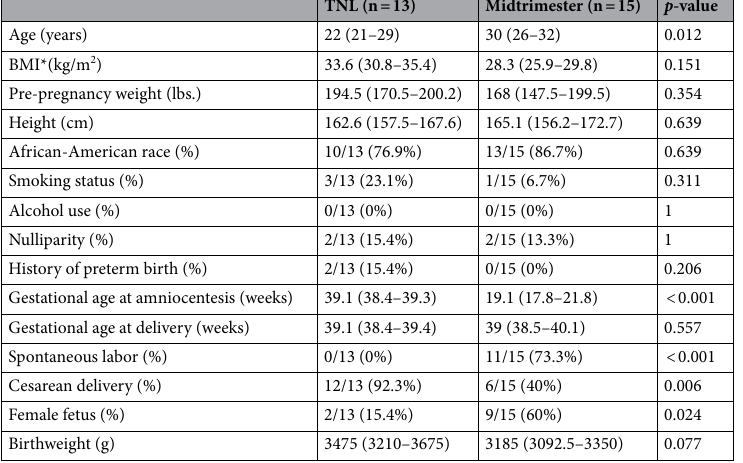
Table 1. Demographic characteristics of the women included in the proteomics study. Continuous variables were compared with a Welch’s t-test and are summarized as medians (interquartile range). Categorical variables are shown as number (%) and were compared by using Fisher’s exact test. BMI body mass index; TNL: term not in labor. *Contains one missing data.